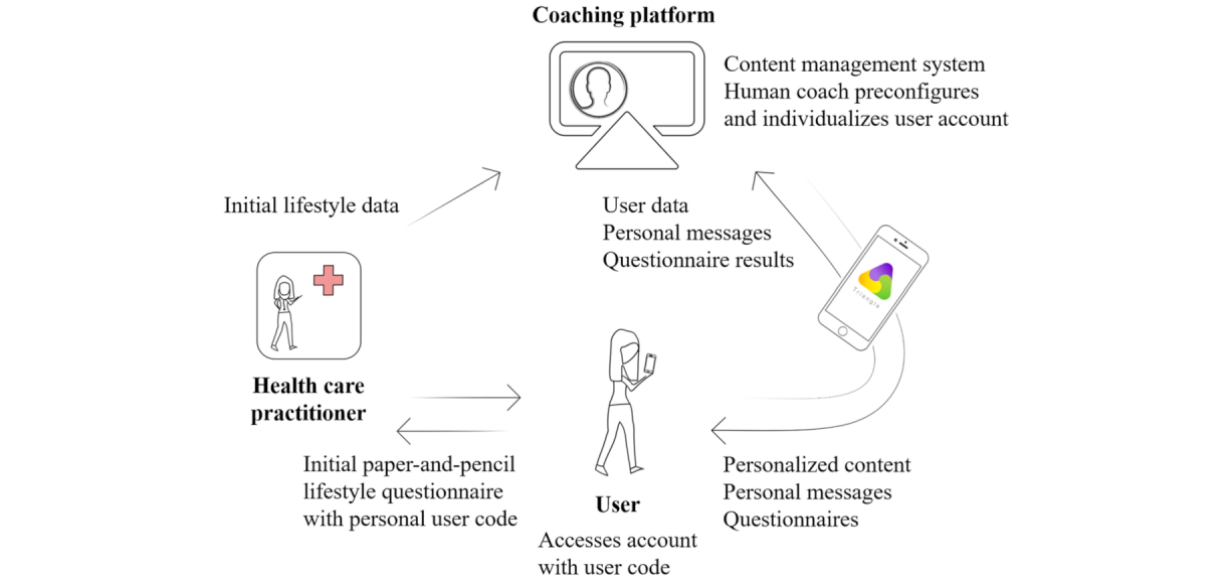
Figure 1. TRIANGLE app onboarding and